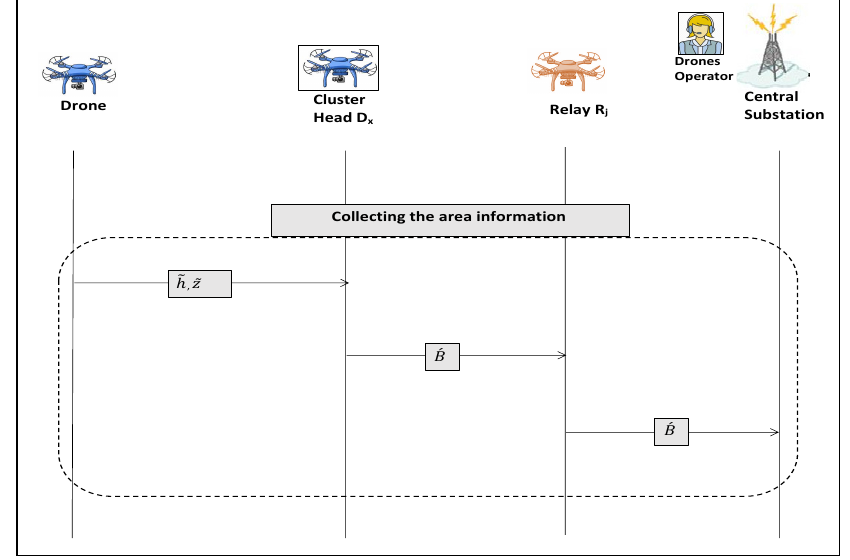
Figure 3. Surveillance UAV network operation phase collecting the area